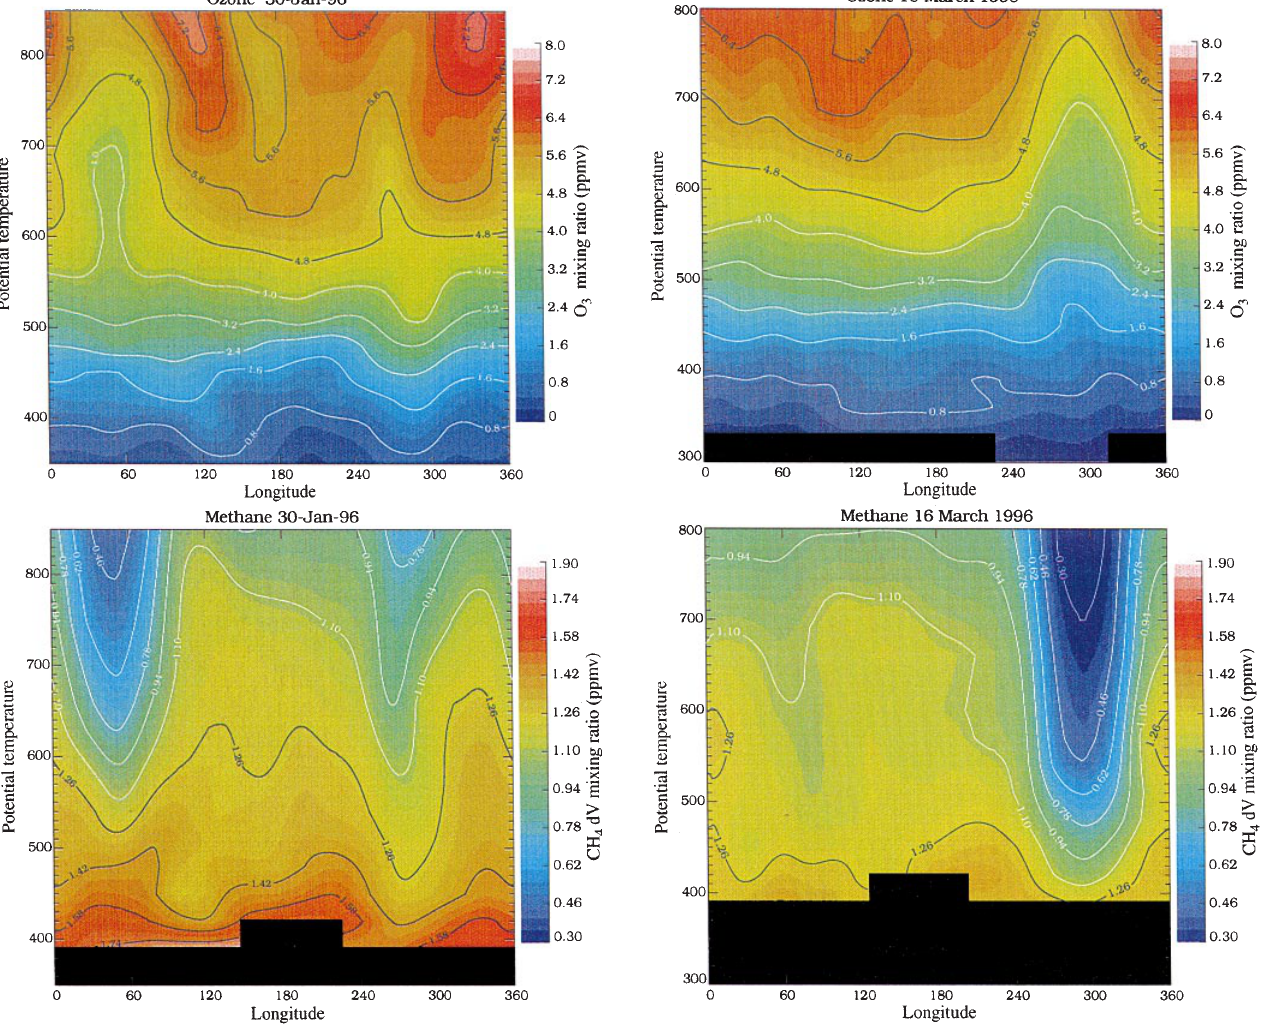
Fig. 4. As Fig. 2 but for sunrise observations on March 16, 1996 (uarsday 1648), at 64 (cid:14) N. Vortex air is discernible over the whole altitude range at 294